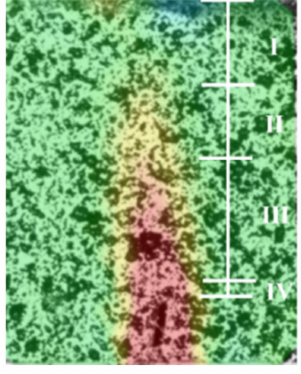
Figure 8. Crack tip